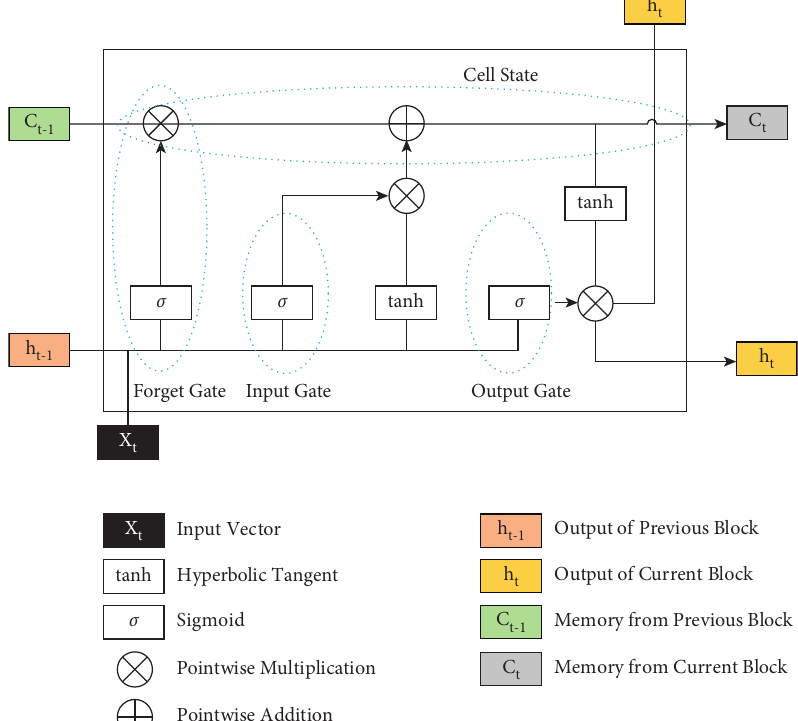
Figure 4: LSTM memory cell with three gated layers: forget gate f c t [38].